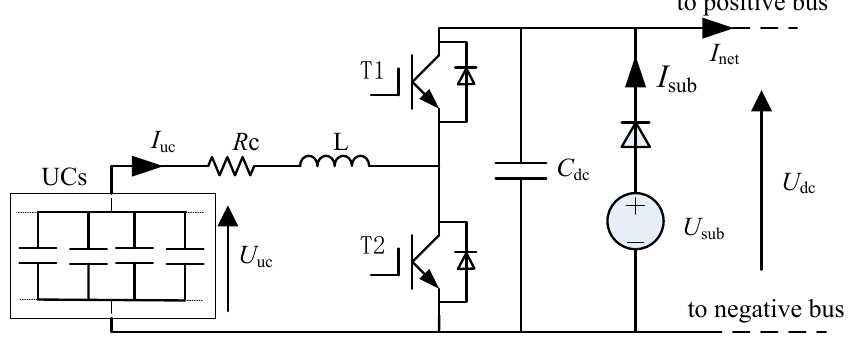
Figure 2. UCs coupled by the bidirectional DC/DC converter with